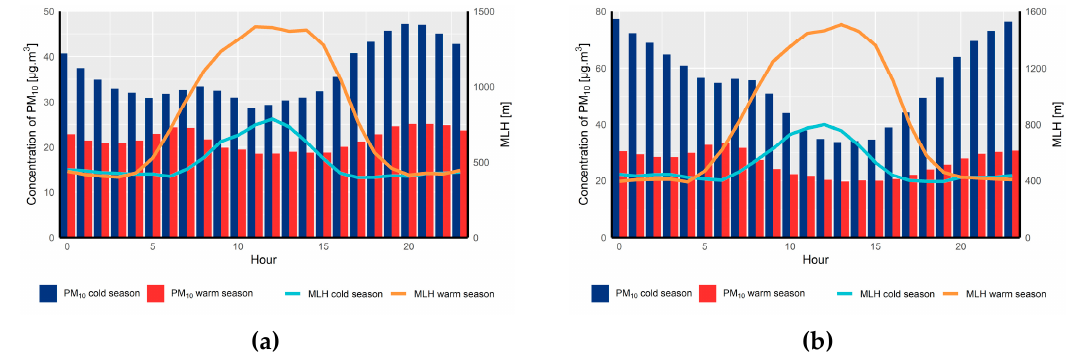
Figure 3. Daily course of hourly PM 10 concentrations and mixing layer height (MLH), 2016–2019: ( a ) T ř inec-Kosmos; ( b ) V ěřň ovice.